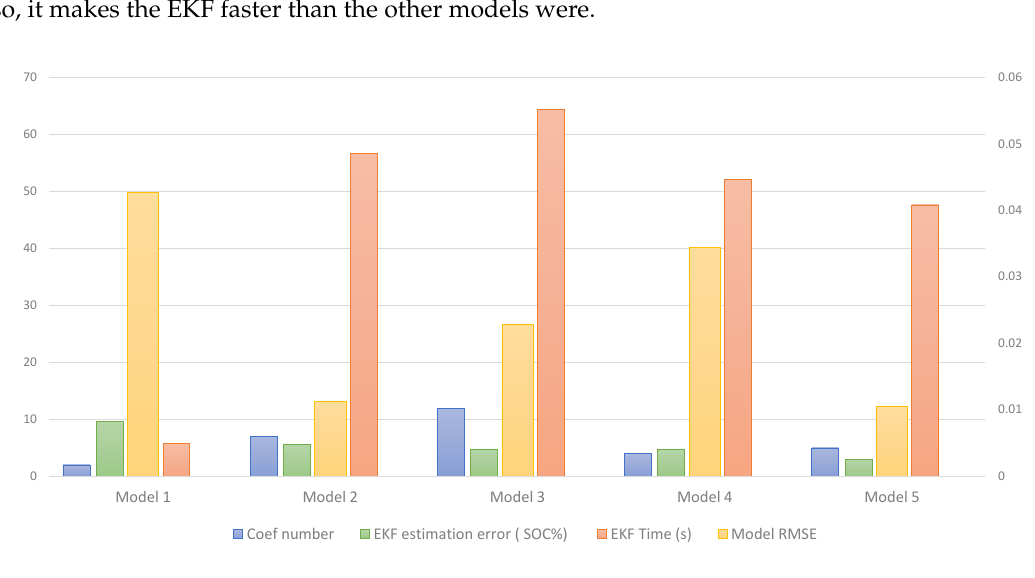
Figure 17. Comparison of the studied OCV models’ performances at 25 ◦